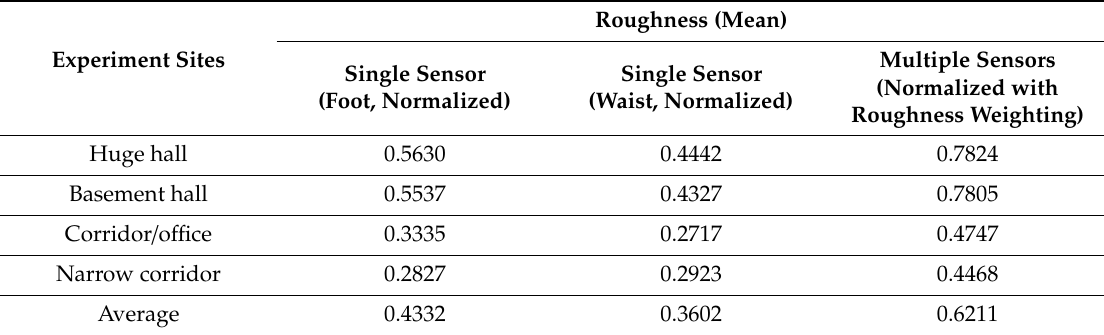
Table 1. Comparison of the roughness in various environments.